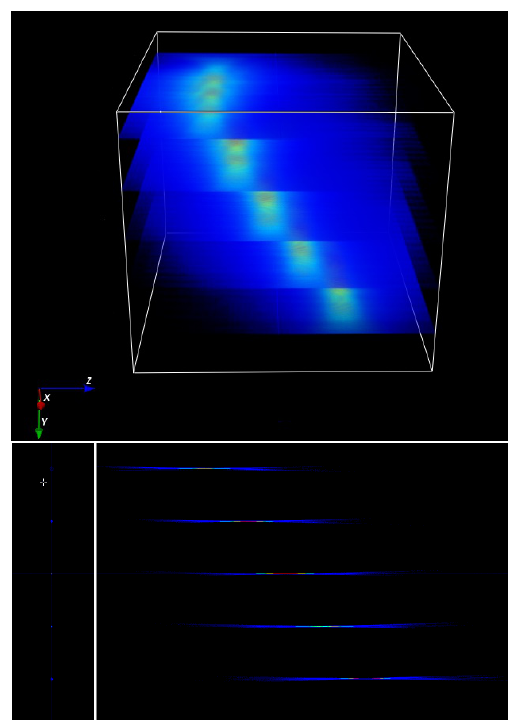
Figure 4. Measurement chamber with inserted FEP-tube filled with water and illuminated by the multiple light